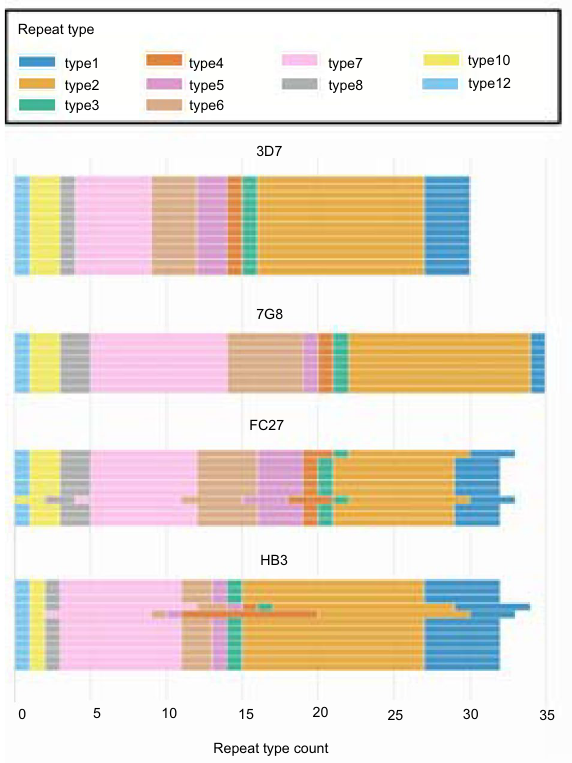
Figure 4. Repeat-type profiles from reference strain experiments. Each colored bar indicates the count of a particular repeat type in exon 2 of pfhrp2 as color-coded in the legend. Each row represents a single contig constructed based on de novo assembly performed on reads that successfully aligned to the pfhrp2 3D7 reference sequence. Due to the repetitive nature of exon 2, minor variations in contig construction, as seen here for FC27 and HB3, can be expected, even in monoclonal